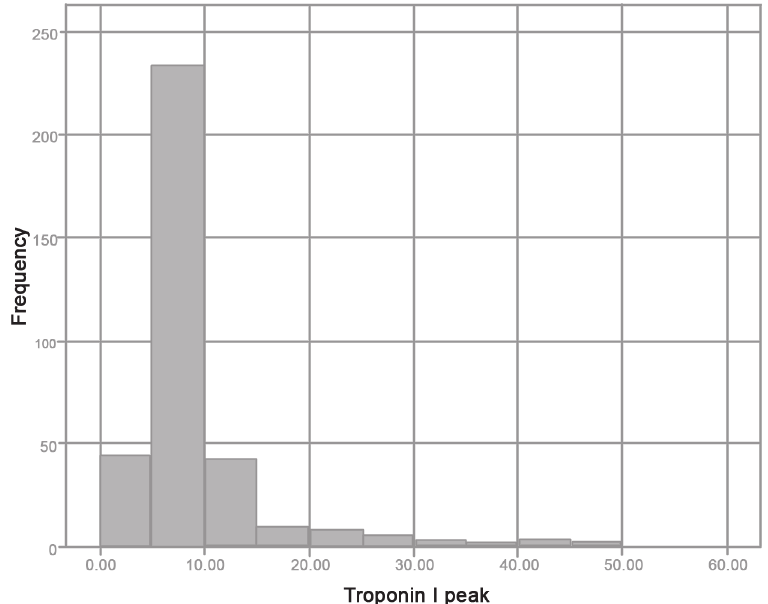
Fig 1. Overall pattern of 24-hour troponin release.